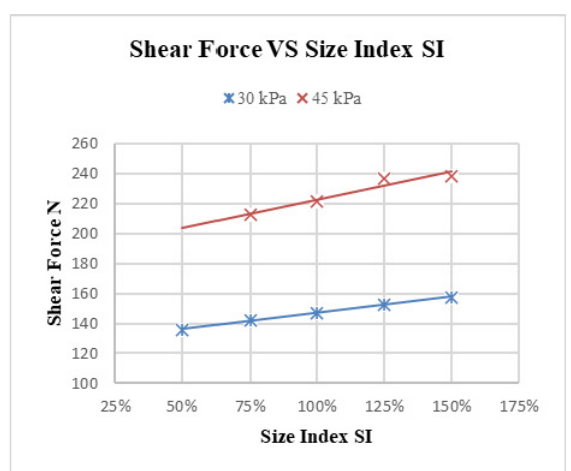
Figure 5 Shear stress with a variety of SI at 30 kPa and 45 kPa normal